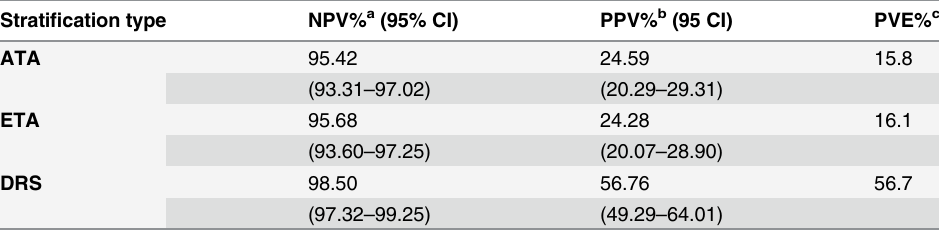
Table 4. PPV, NPV and PVE according to the different risk stratification systems. Strati fi cation